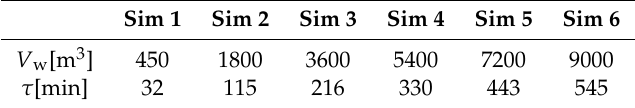
Figure 11. The effect of water volume on the water basin temperature. Table 4. Thermal time constants for the basin enlarging